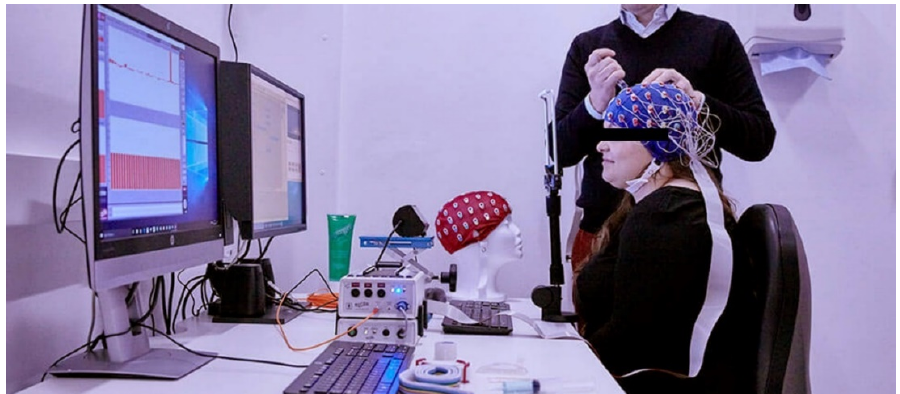
Figure 5. The EEG measurement tools, by authors.